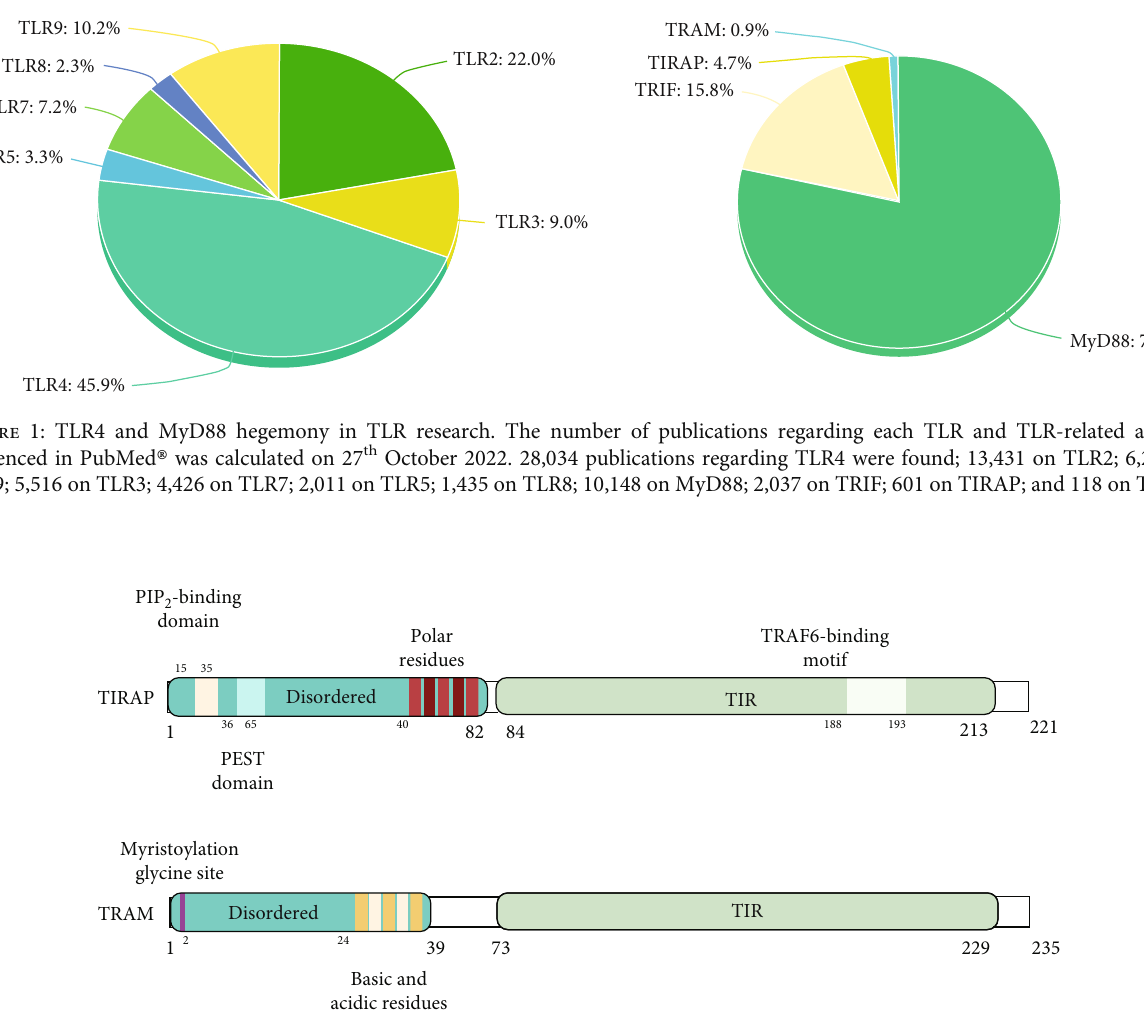
-binding motif and a PEST 2